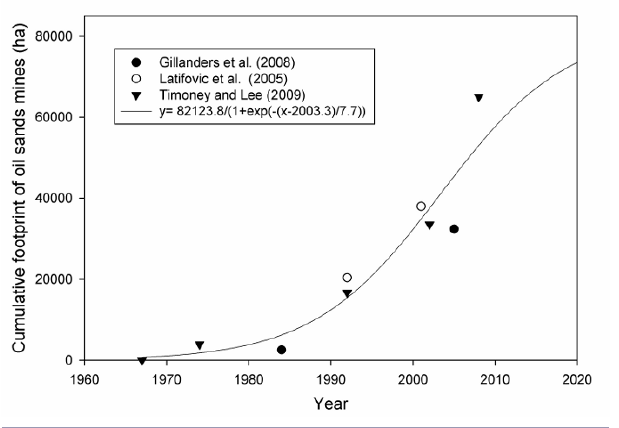
Fig. 2 . Growth of the oil sands mining “footprint” in the Athabasca region since 1967. Data are derived from Latifovic et al. (2005), Gillanders et al. (2008), and Timoney and Lee